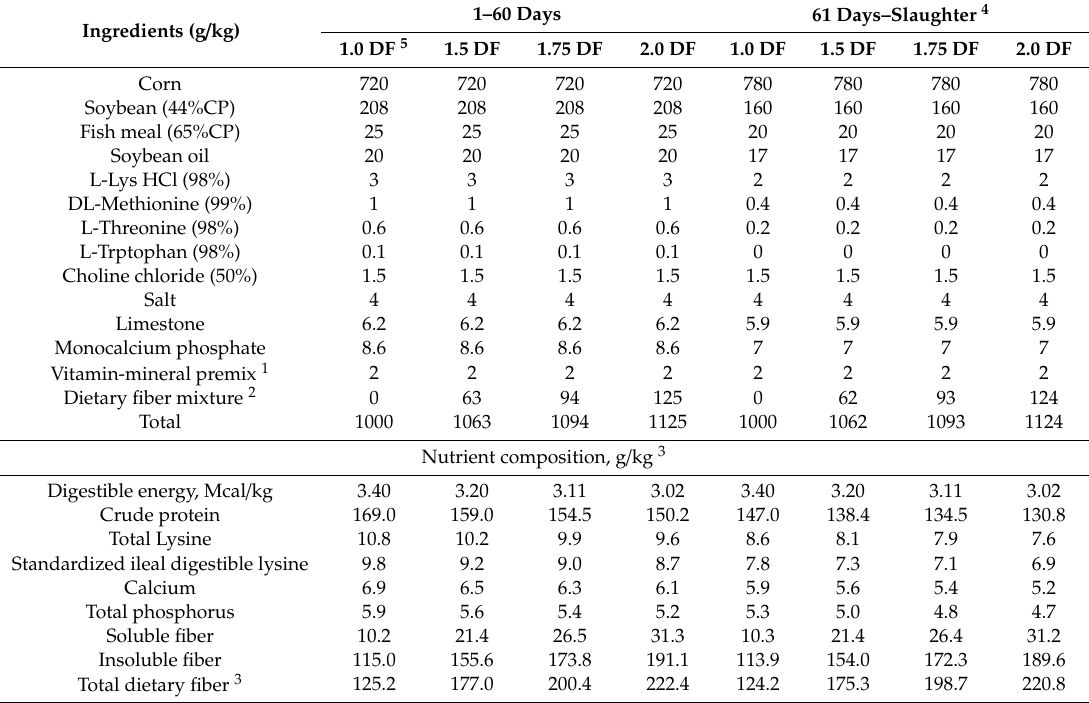
Table 1. Ingredients and chemical composition of basal diets (g / kg, as fed